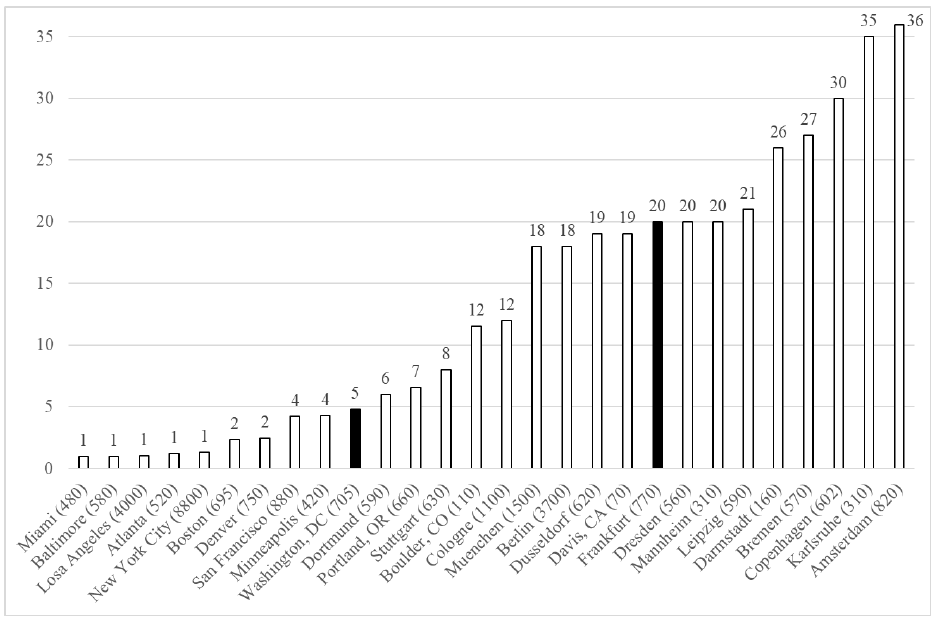
Figure 5. Percent of trips made by bicycle in U.S. cities, German cities, Copenhagen, and Amsterdam, 2017–2019. Note: Data for US cities are for the commute to work only. Population size of the city in parenthesis. Sources: [30,31].